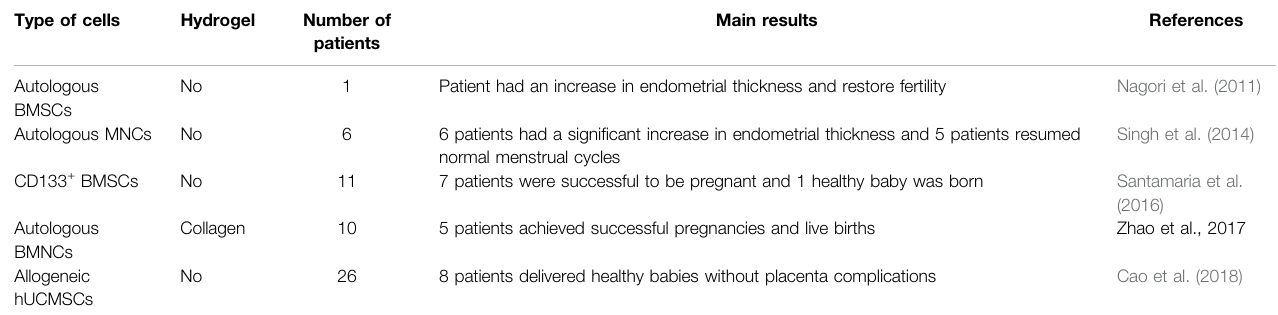
TABLE 1 | Clinical trials of stem cell therapy for IUA.